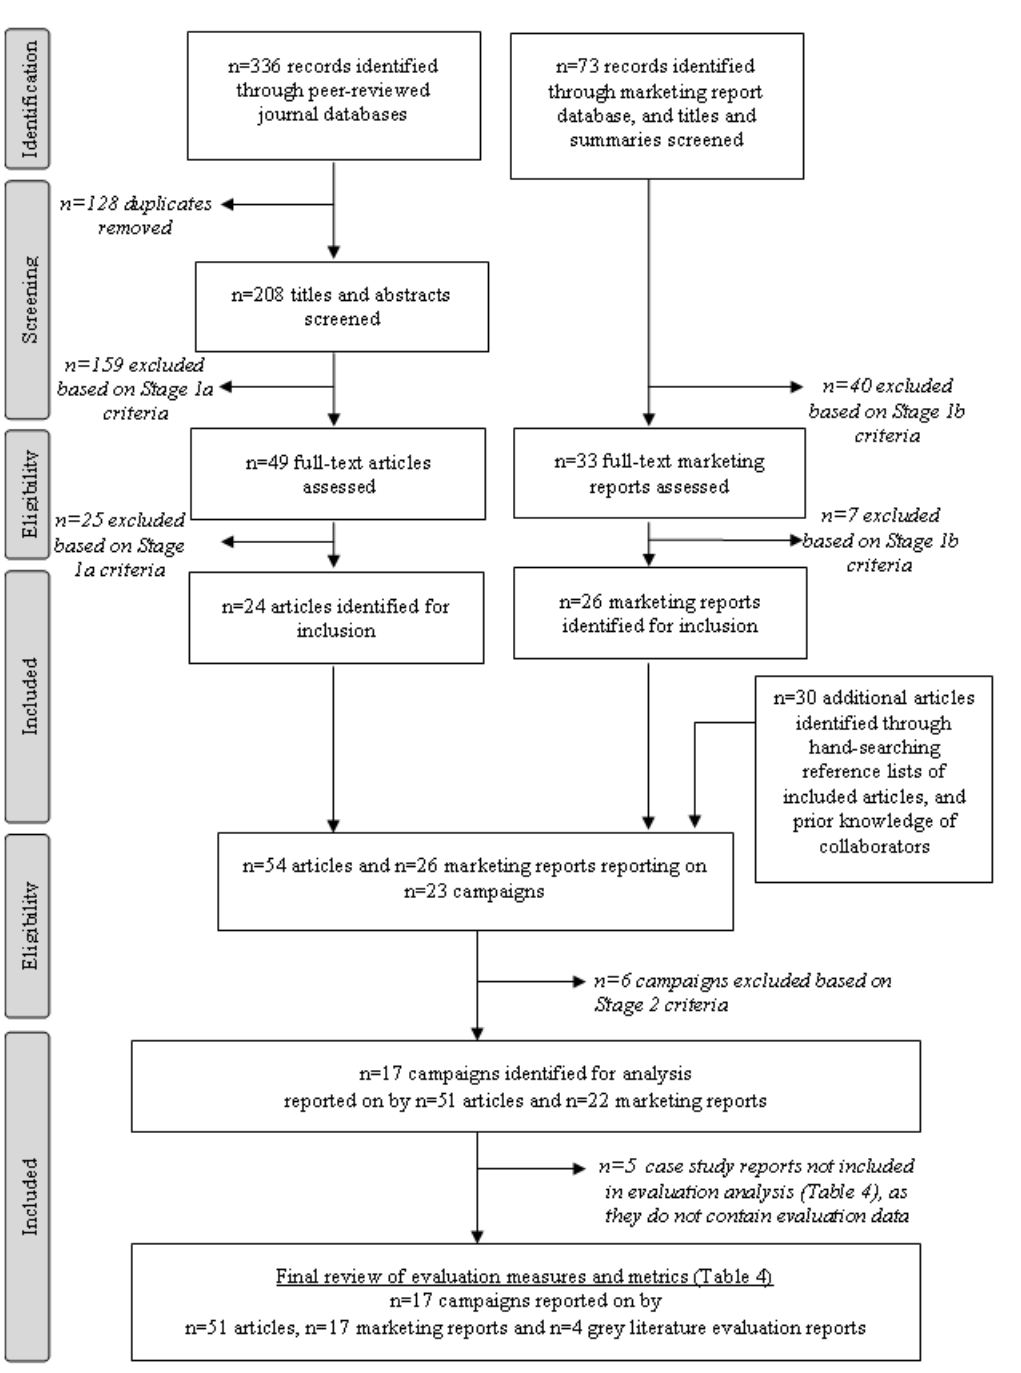
Figure 1. Flowchart of search strategy and campaign